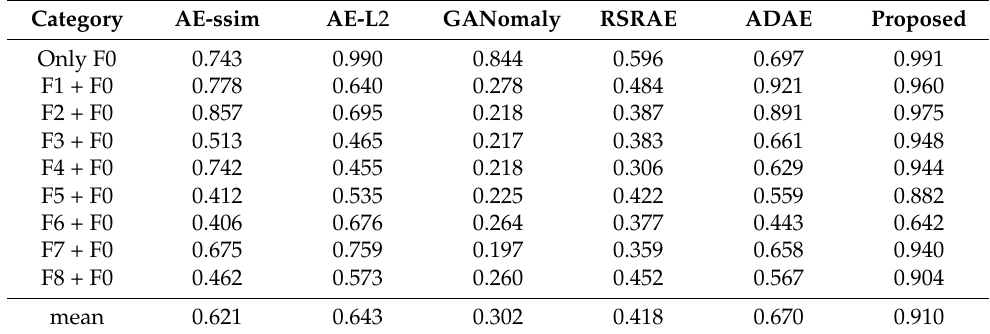
Table 3. The accuracy results of correctly classified anomalous images and normal images for different methods and the proposed